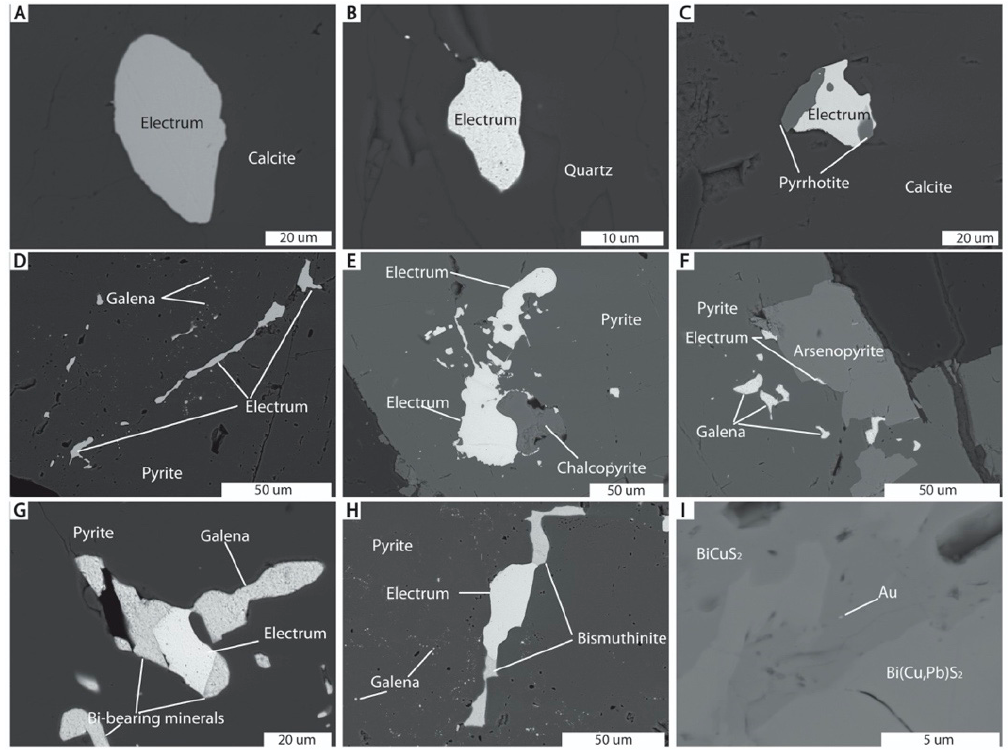
Figure 6. FE-SEM images of micro to nano-sized inclusions in quartz-calcite veins; ( A ) Anhedral micro inclusion of electrum in calcite microvein; ( B ) Anhedral micro inclusion of electrum in quartz vein; ( C ) Electrum in intergrown texture with pyrrhotite in calcite microvein; ( D ) Electrum filling fracture in pyrite, associated with galena; ( E ) Electrum along grain boundaries between pyrite and chalcopyrite; ( F ) Electrum along grain boundaries between pyrite and arsenopyrite, in association with galena; ( G , H ) Electrum and Bi-bearing minerals along grain boundaries in pyrite; ( I ) nano inclusion of Au in Bi-bearing mineral.